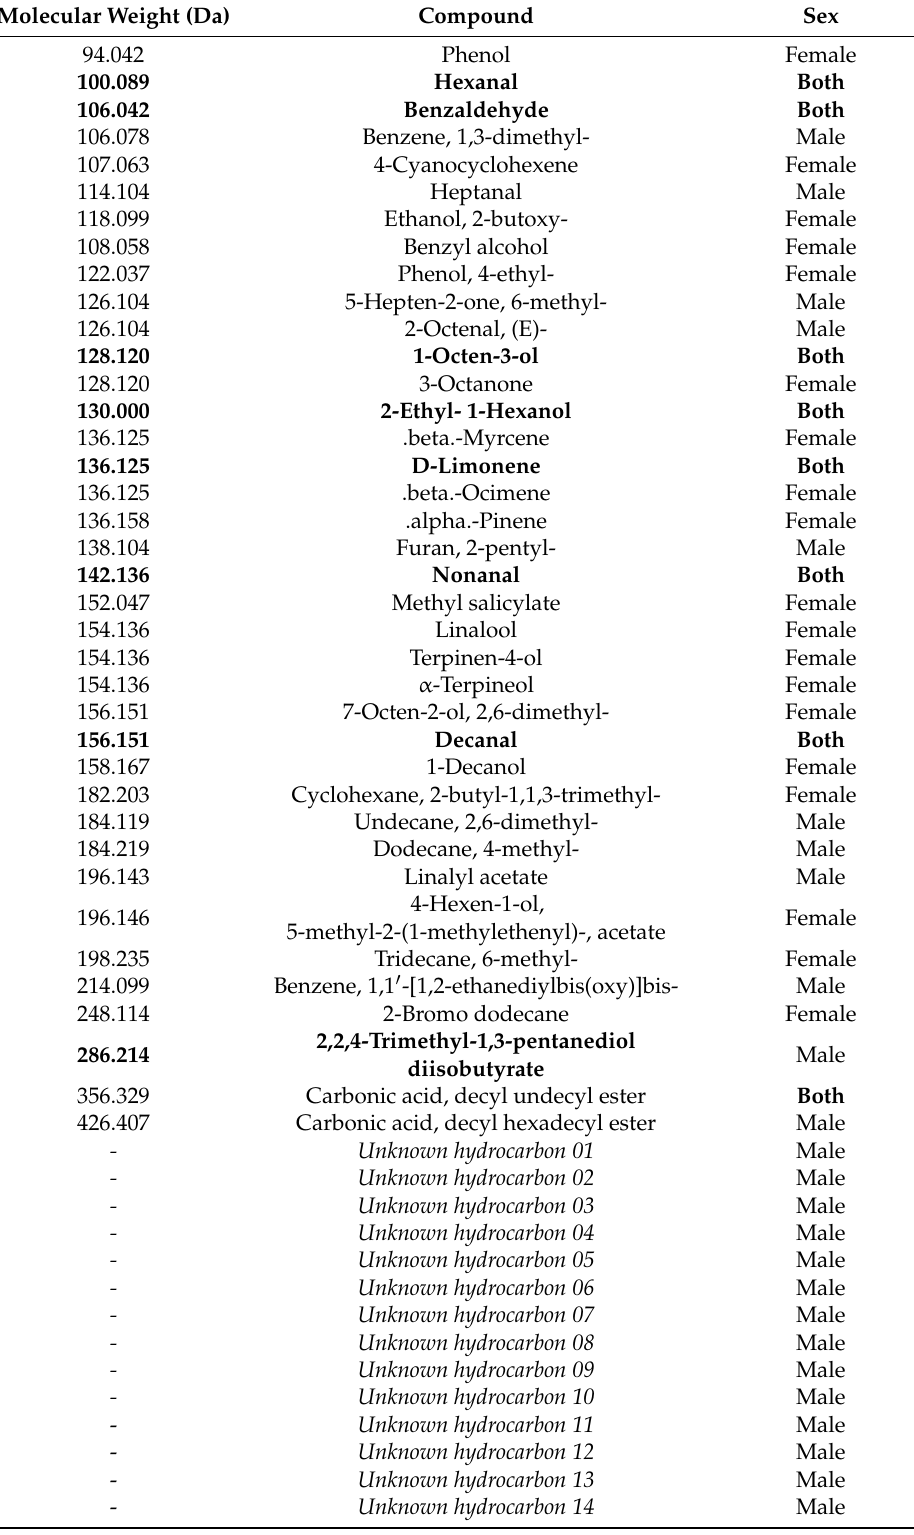
Table 3. Volatile compounds present in filter paper samples from male and female ano-genital odour secretions identified tentatively using ChemStation (Agilent Technologies) and NIST (version MSD F.01.01.2317) mass spectral databases, listed in order of retention time. Compounds in bold font were found in both male and female